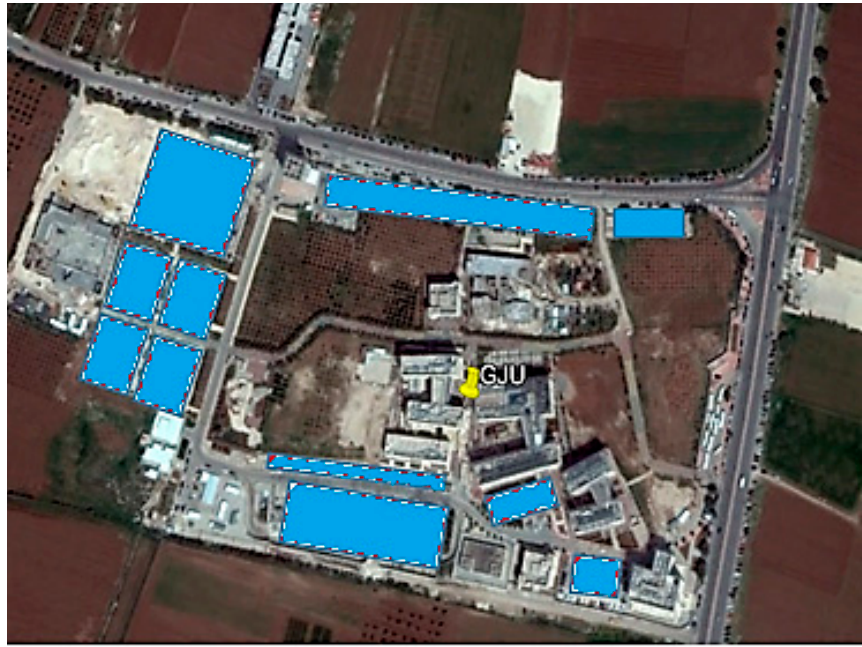
Figure 2. Photovoltaic (PV) technology layout over the German Jordanian University (GJU) cam- pus.